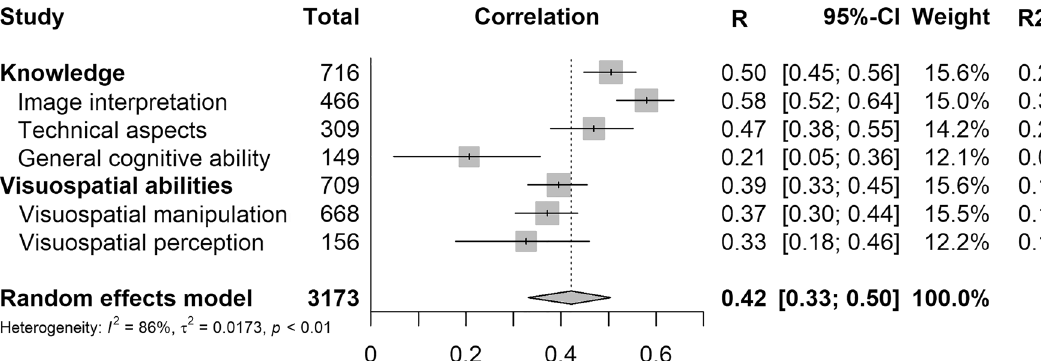
Fig. 2 Forest plot of the pooled correlations of the included studies divided by cognitive domain. R correlation coefficient. 95% CI 95% Confidence Interval. R2 determination coefficient. The pointed line represents the pooled correlation of the random effects model of all included studies, the grey box represents the weight of the studies. I 2 fraction of variance due to heterogeneity. T 2 the estimated standard deviation of underlying effects across the studies